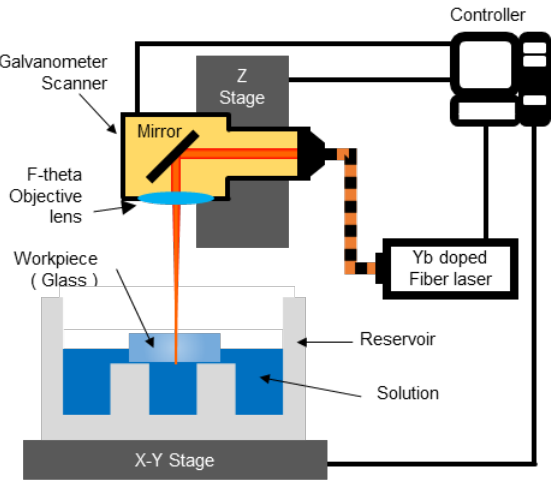
Figure 3. Schematic diagram of the LIBWE and LCLD systems.